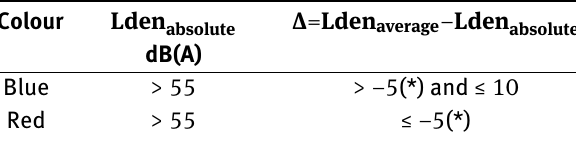
Table 4: Possible categories of QUAs established using the modified rQUA method.